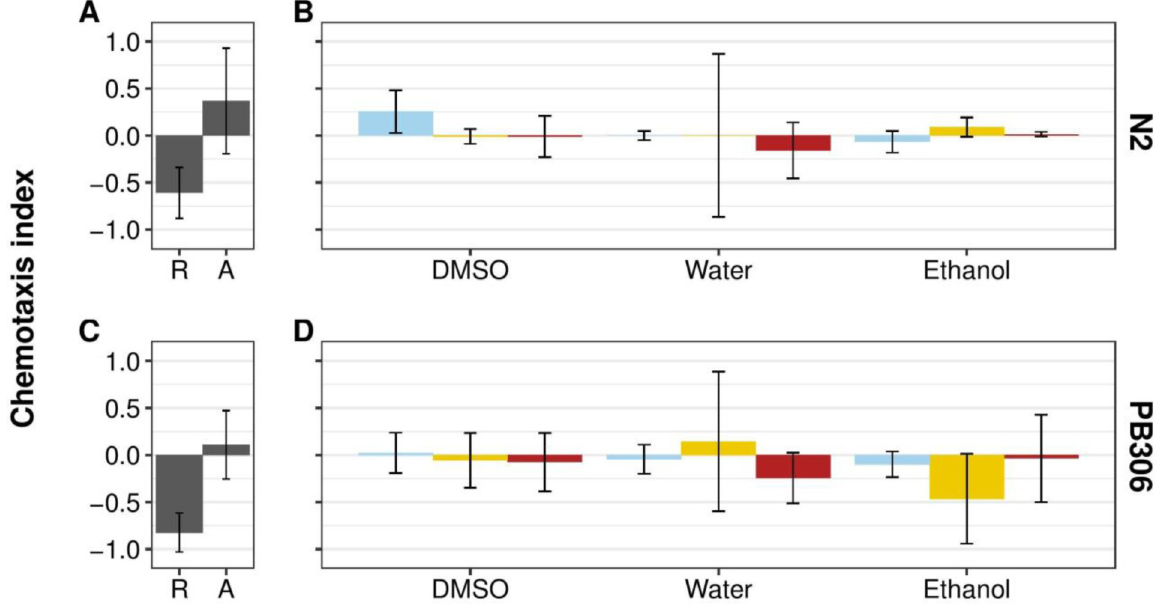
Fig 2. C . elegans N2 and PB306 dauer animals do not respond to P . scaber washes with three different solvents. (A) and (C) Plot of undiluted 1-octanol repulsive (R) and isoamyl alcohol diluted to 10 − 3 in ethanol attractive (A) reference control chemotactic indices for the N2 and PB306 dauers. (B) and (D) Plot of chemotactic indices of N2 and PB306 dauer C . elegans to undiluted P . scaber washes compared to neutral control references. Blue bars represent the neutral control of solvent alone. Yellow bars represent chemotactic indices to washes that were prepared from male isopods. Red bars represent chemotactic indices to washes that were prepared from female isopods. From left to right, each grouping of bars represents dimethyl sulfoxide (DMSO), deionized water, and ethanol washes (n = 40–50 animals per condition, per replicate). Error bars are standard deviation. No isopod wash was significantly different from its corresponding neutral control (see S5 Table for p values).